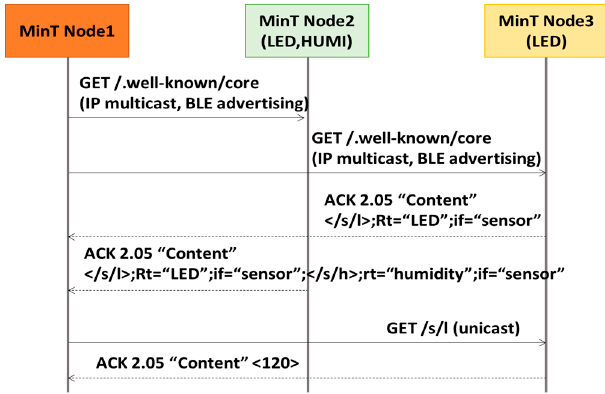
Figure 7. Sequence diagram for resource discovery and resource request in CoAP.